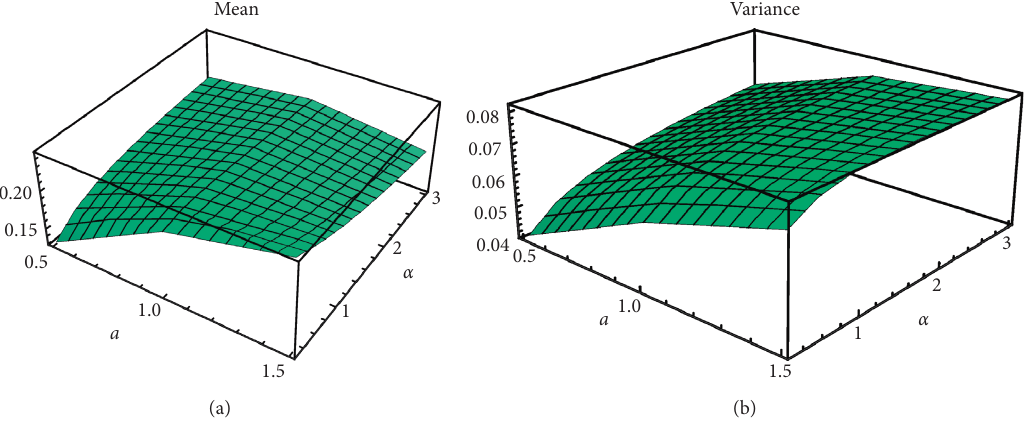
Figure 2: Plots of the mean and variance for the APTIL distribution.